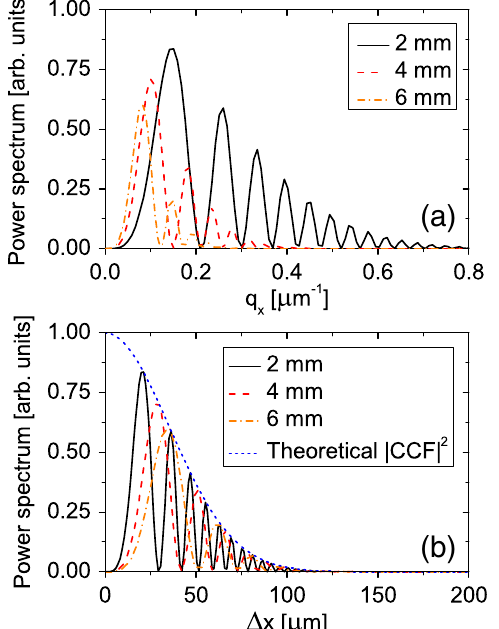
FIG. 5. (a) Simulated horizontal profiles of power spectra for different sample-detector distances. (b) Master curve for spatial coherence obtained through the scaling described in Eq. (9). The common envelope of the reduced power spectra fits the theo- retical squared modulus of the radiation CCF of the form exp ð − Δ x 2 = σ 2 Þ . Parameters used in the simulation are λ ¼ coh 440 nm and σ 50 μ m. coh ¼